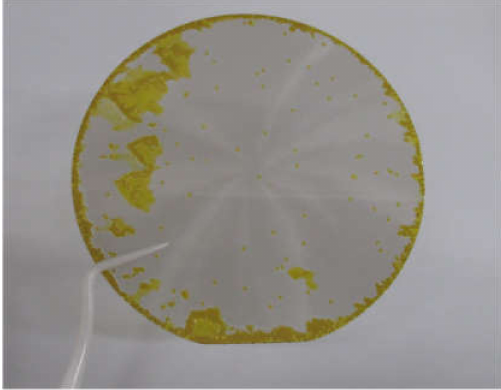
Figure 12. Photograph of the 3-inch on-axis 4H-SiC free-standing epitaxial